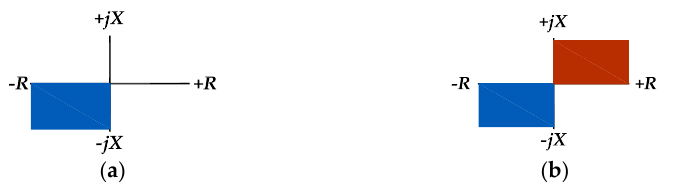
Figure 4. Fault discrimination characteristics: ( a ) internal faults; ( b ) external faults.